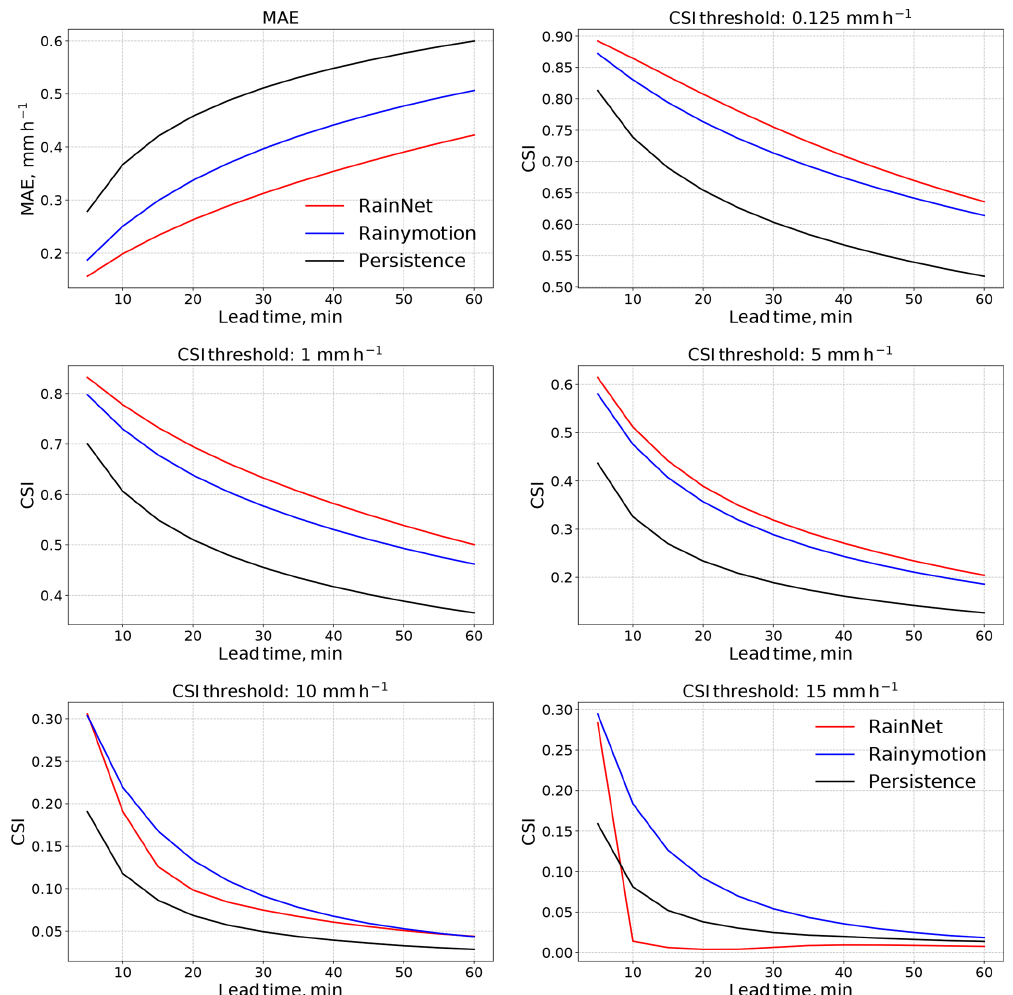
Figure 3. Mean absolute error (MAE) and critical success index (CSI) for five different intensity thresholds (0.125, 1, 5, 10, and 15mmh − 1 ). The metrics are shown as a function of lead time. All values represent the average of the corresponding metric over all 11 verification